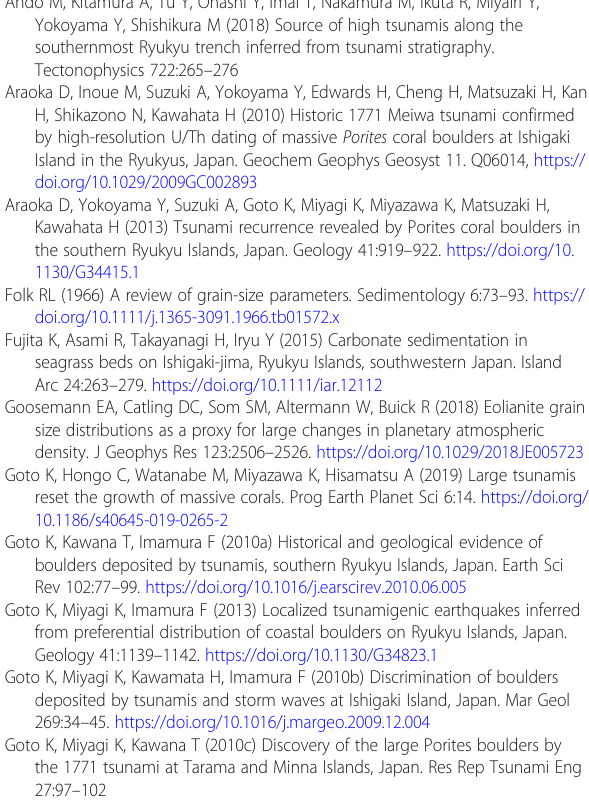
Additional file 1: Fig. S1. Close-up photographs of sands in L1 –